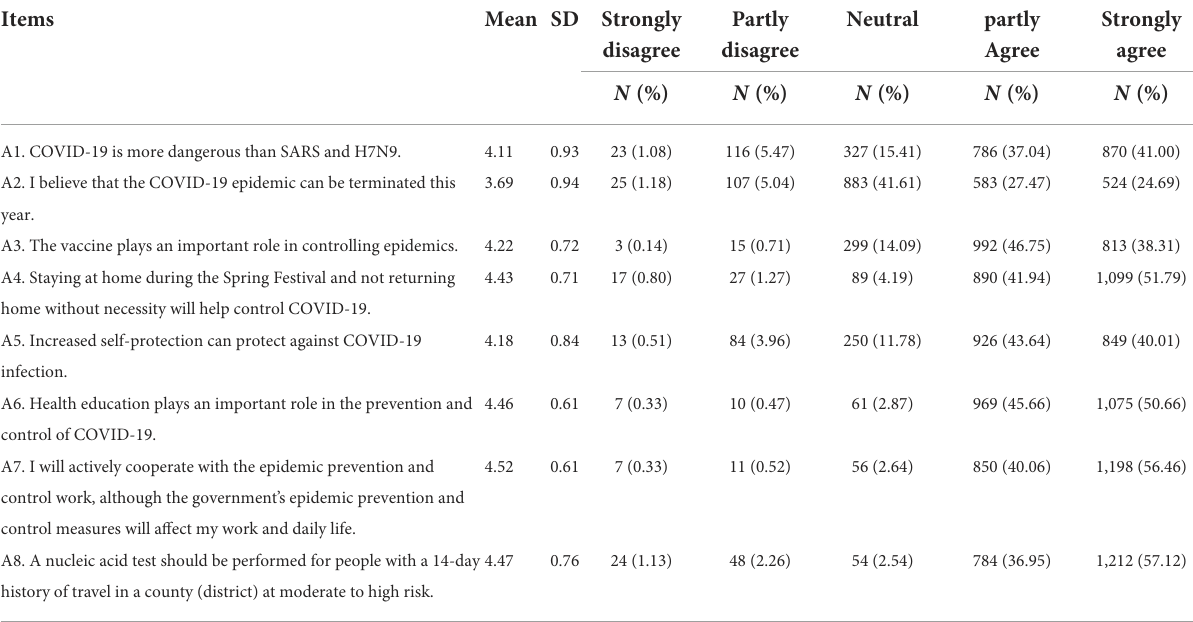
TABLE 4 Attitude toward COVID-19 ( N =